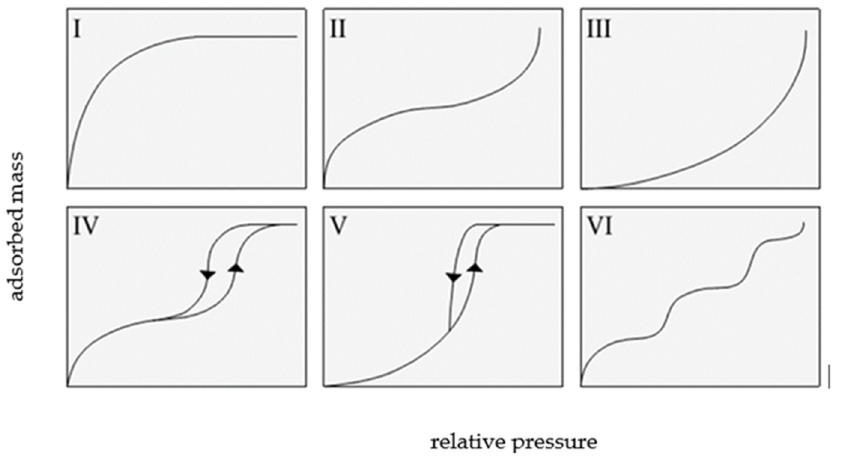
Figure 2. The types of isotherms according to IUPAC, based on [2]. IUPAC isotherms of type I, II, and III overlap with type I, II, and III of the Brunauer